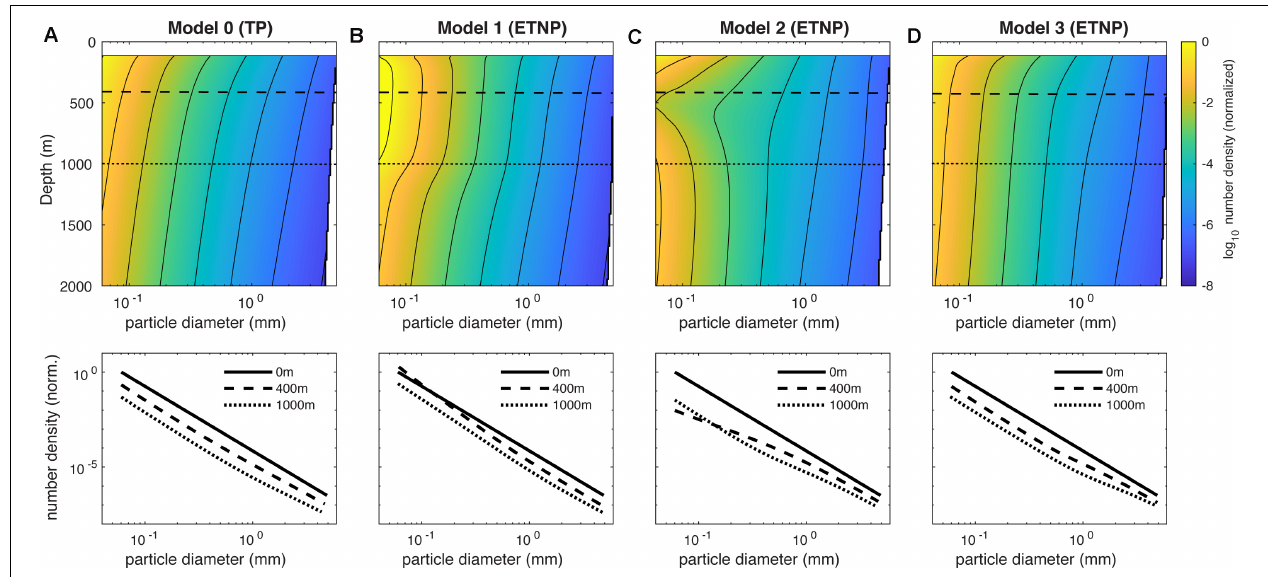
FIGURE 4 | Predicted particle size spectra in our mechanistic model. (A) , Upper panel shows the particle number density predicted in the TP region by Model 0, as a function of depth and particle diameter. Number density in #mm − 1 is normalized to the abundance of the smallest size class in the surface ocean, yielding a dimensionless size spectrum. Lower panel shows the surface size spectrum (solid line, slope = –3.4) and “slices” through the spectrum at depths of 400 m (oxygen minimum) and 1000 m (lower oxycline), which are indicated on the upper panel as dashed and dotted lines, respectively. (B–D) , Same as (A) , but showing the size spectra predicted by Models 1–3 in the ETNP region. Each of these models predicts unique differences in the OMZ size spectra relative to the oxic water column.